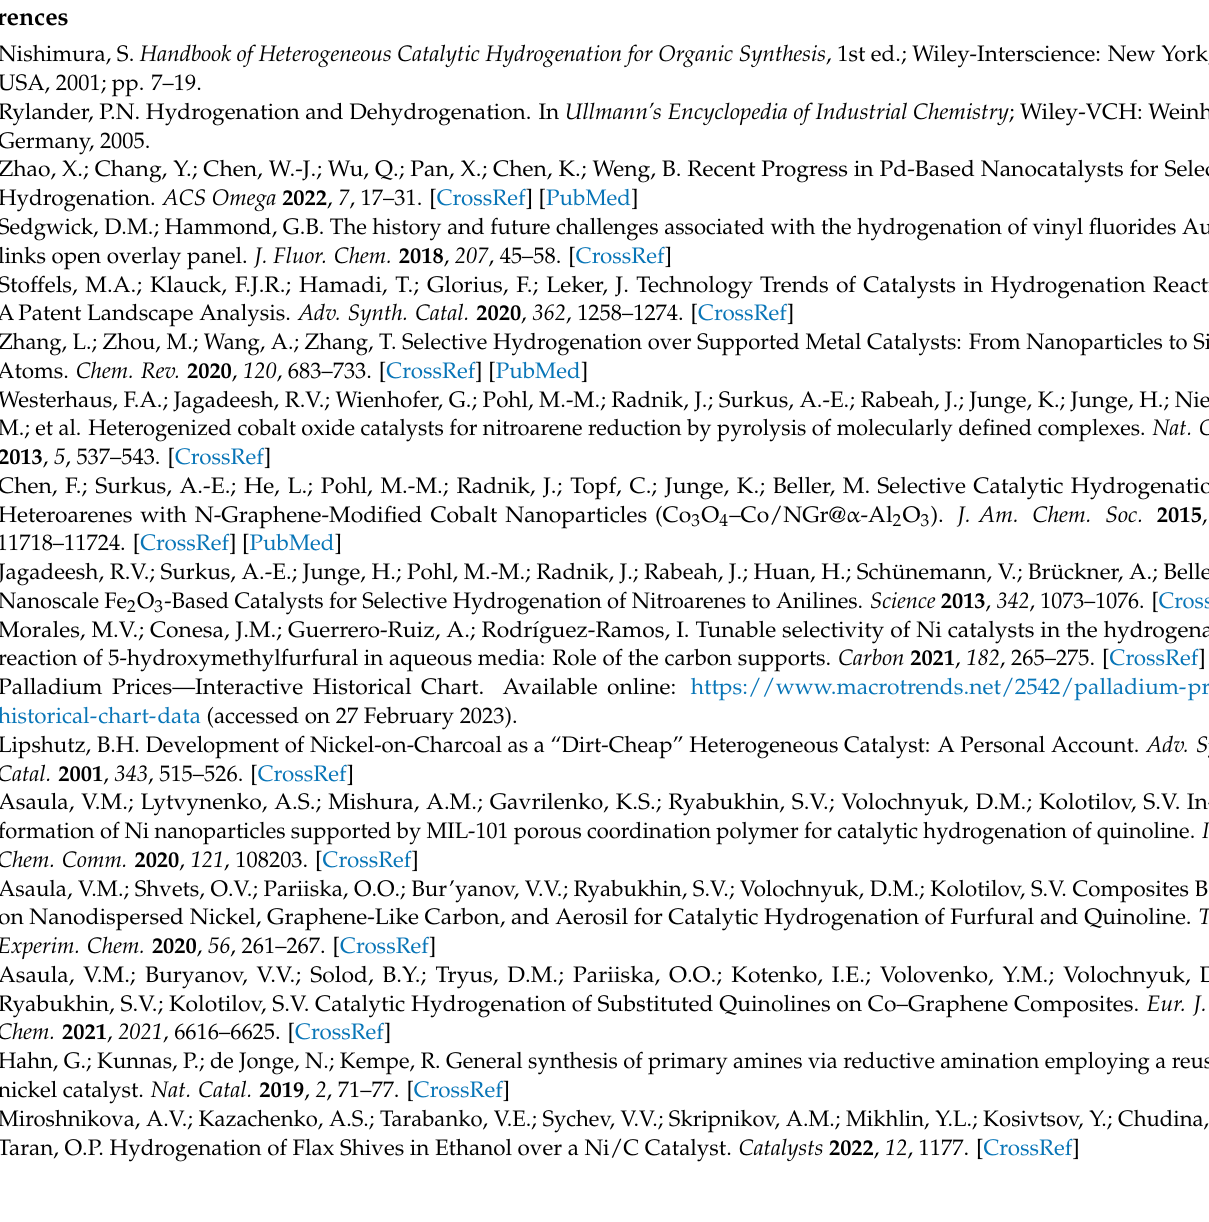
Figure S29. 1 H NMR spectrum of